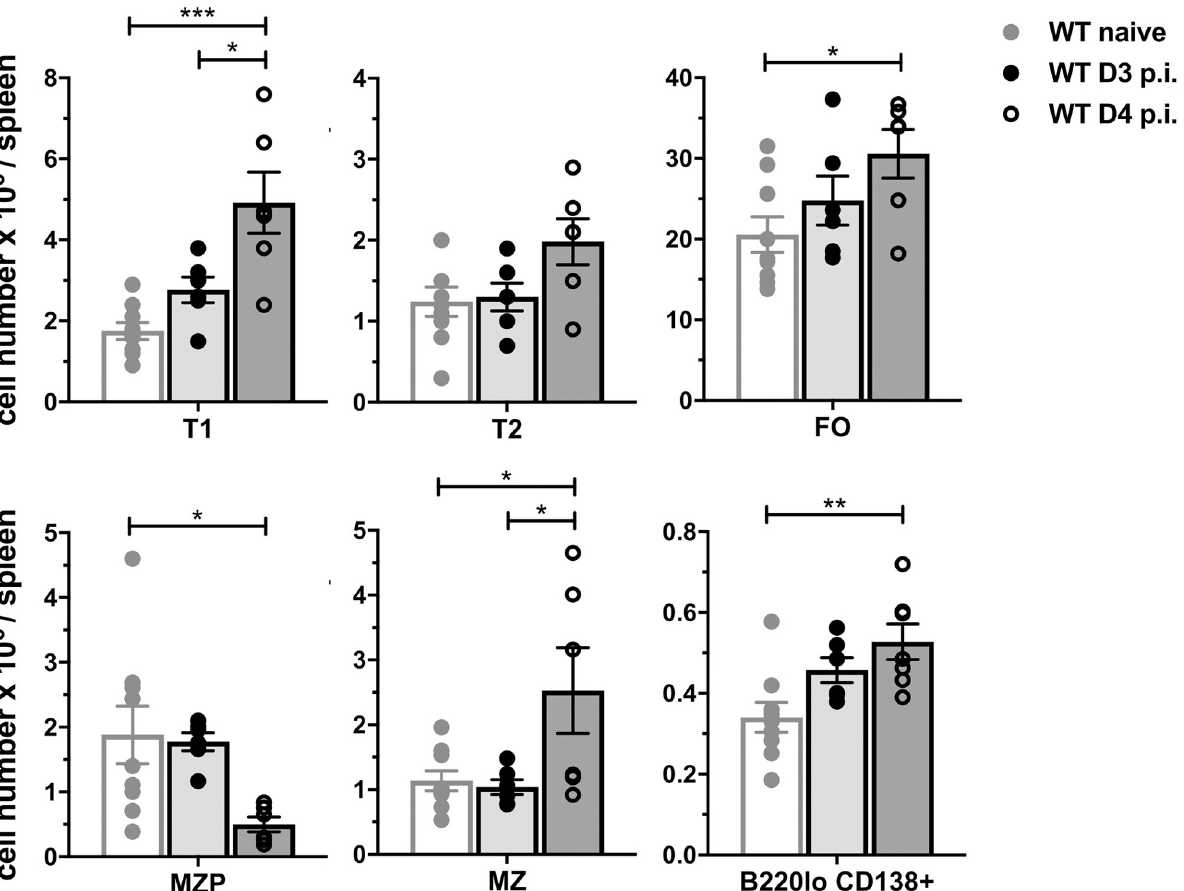
Fig 5. S . typhimurium induces expansion of T1, FO B cells and plasma cells. WT mice were infected i.p. with 500 CFU S . typhimurium and absolute numbers of splenic B cell subsets from na ï ve and infected mice were determined by flow cytometry. For gating strategy of B cell subsets see Methods and S3A Fig in S1 File. T1, T1 B cells; T2, T2 B cells; FO, follicular B cells; MZ, marginal zone, MZP, MZ precursors; B220lo CD138 + , plasma cells. Graphs summarize data from three independent experiments (n = 6–9). Bar graphs show means ± SEM; � p < 0.05, �� p < 0.01, ��� p < 0.001, ���� p < 0.0001, as determined by One-Way Anova with Holm-Sidak multiple comparisons